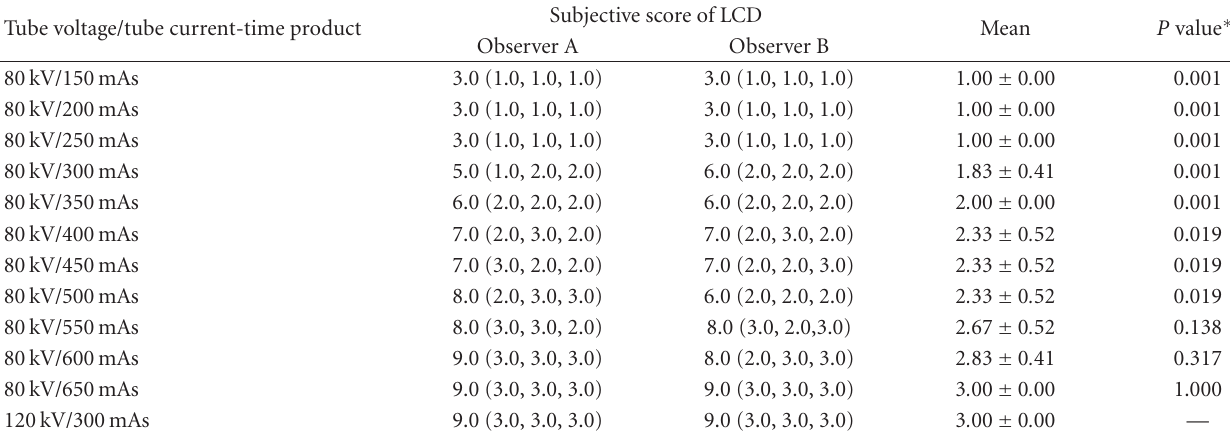
Table 3: The subjective scores of